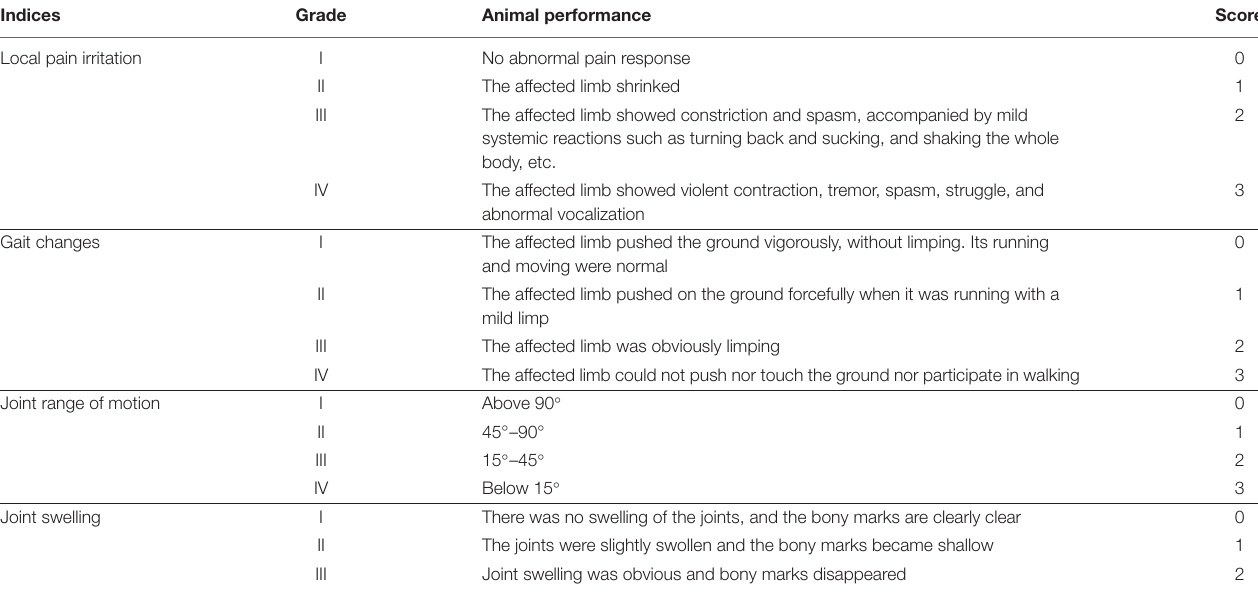
TABLE 1 | Lequensne Index of rabbits’ behavior.